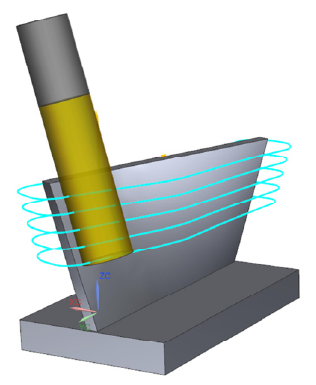
Figure 6. Machining process of Benchmark.